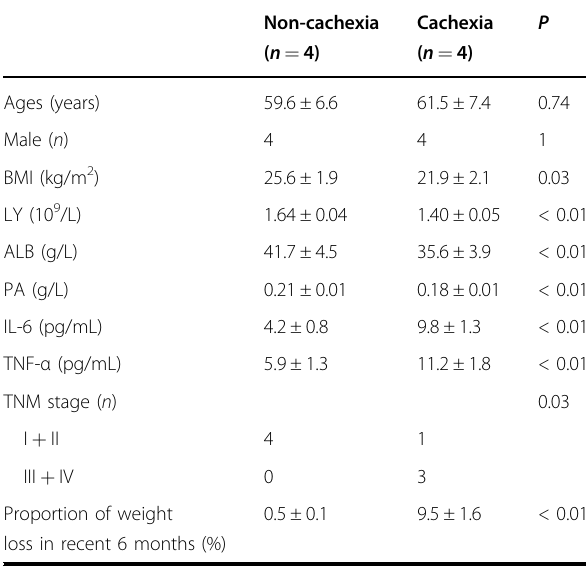
Table 1 Comparison of clinical variables between gastric cancer patients with and without